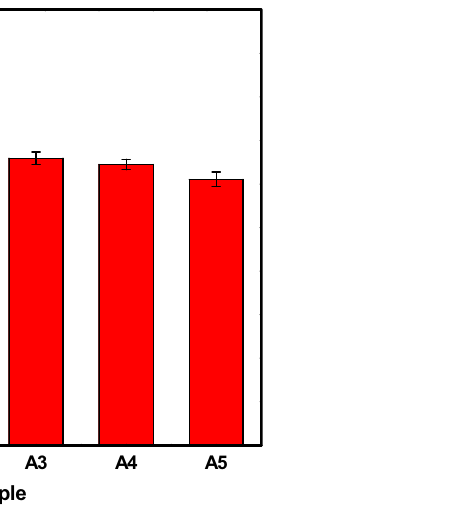
Figure 12. Fracture toughness of the produced